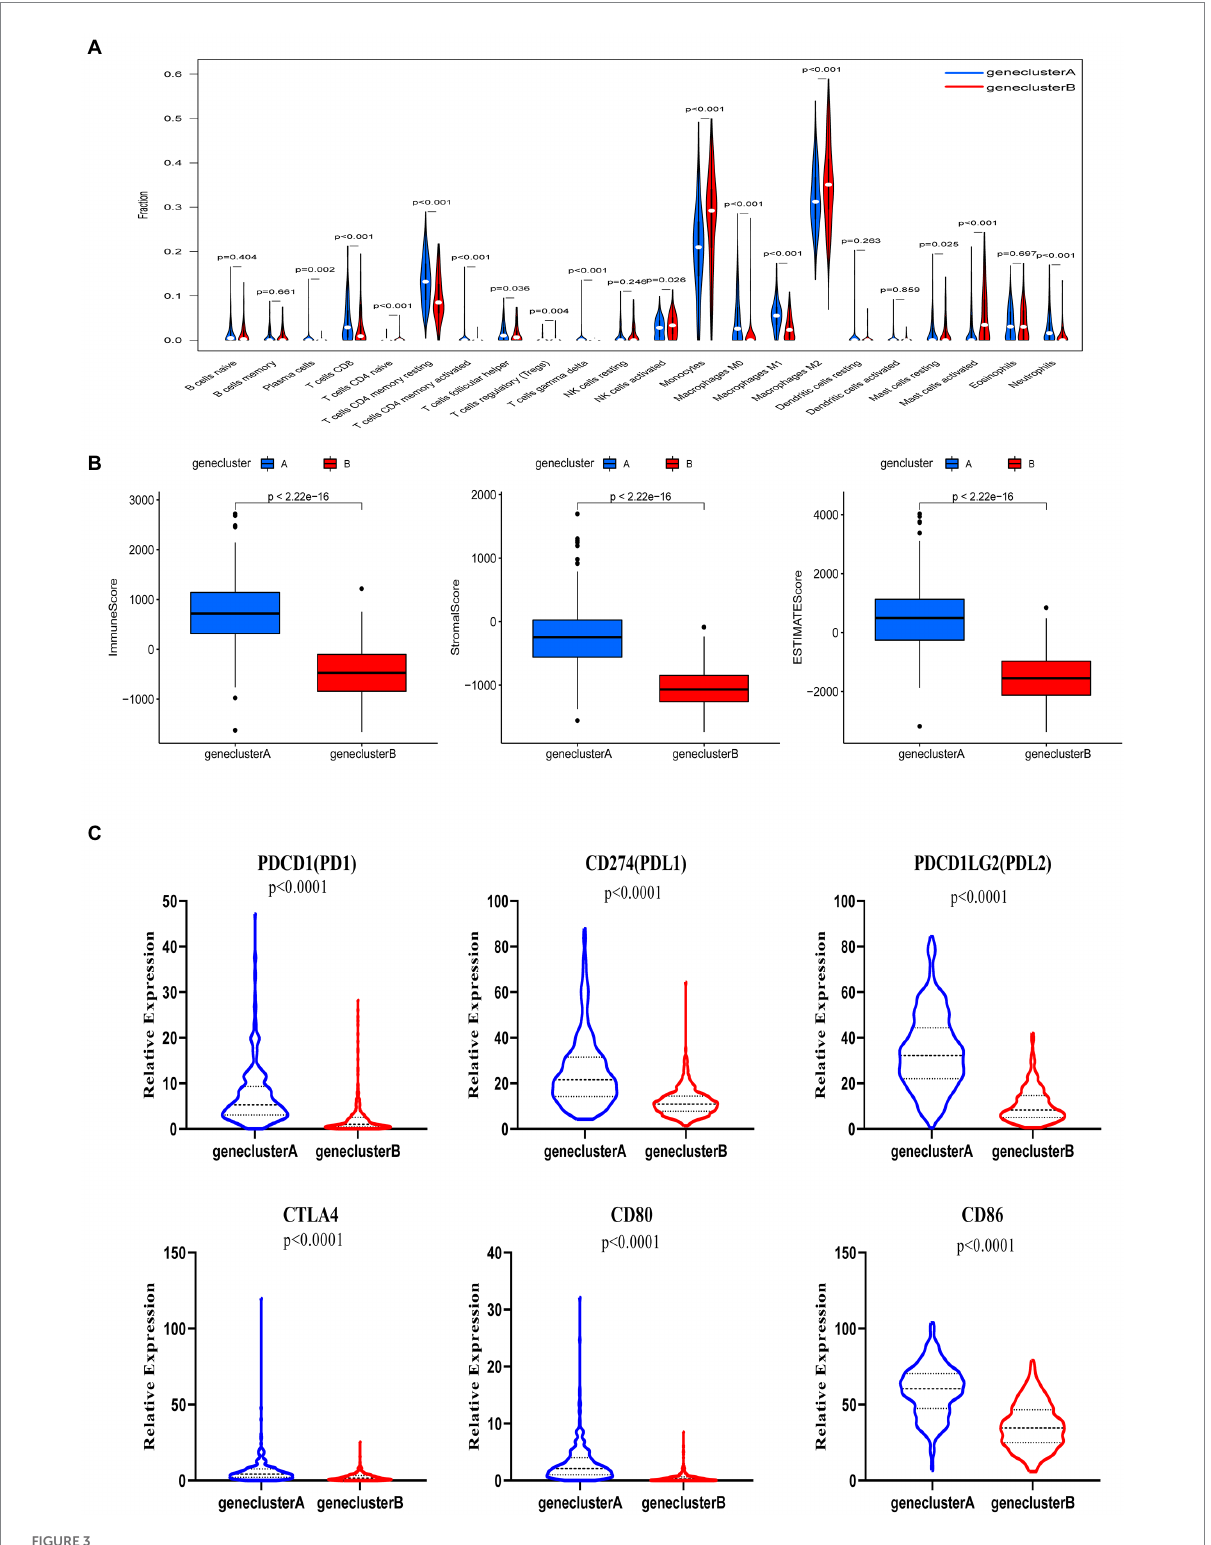
FIGURE 3 Correlations between tumor immune cell microenvironments and two glioma subtypes, defined by differential expression of tryptophan metabolic genes. (A) Abundance of 22 infiltrating immune cell types between the two glioma subtypes. (B) Correlations between the two glioma subtypes and tumor microenvironment score (immune score, stromal score, and ESTIMATE score). (C) Expression levels of PD-1 , PD-L1 , PDL2 , CTLA4 , CD80 , and CD86 between the two glioma